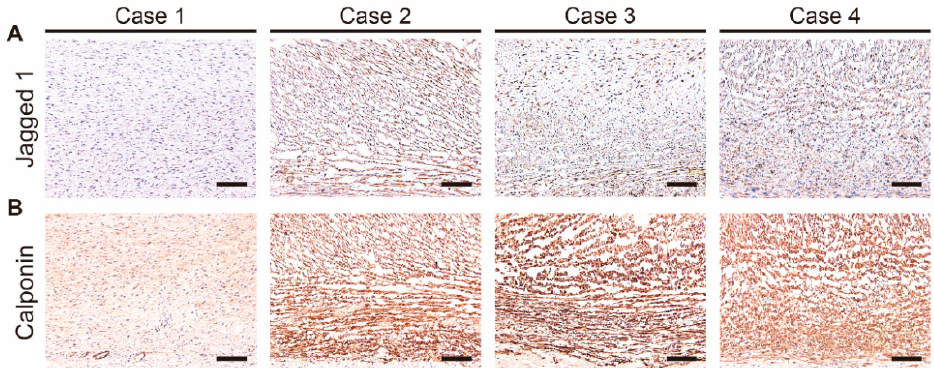
Figure 5. Immunohistochemistry for jagged 1 ( A ) and calponin ( B ) in the human ductus arteriosus tissues from Cases 1–4. A brown color indicates positive immunostaining. Scale bars: 100